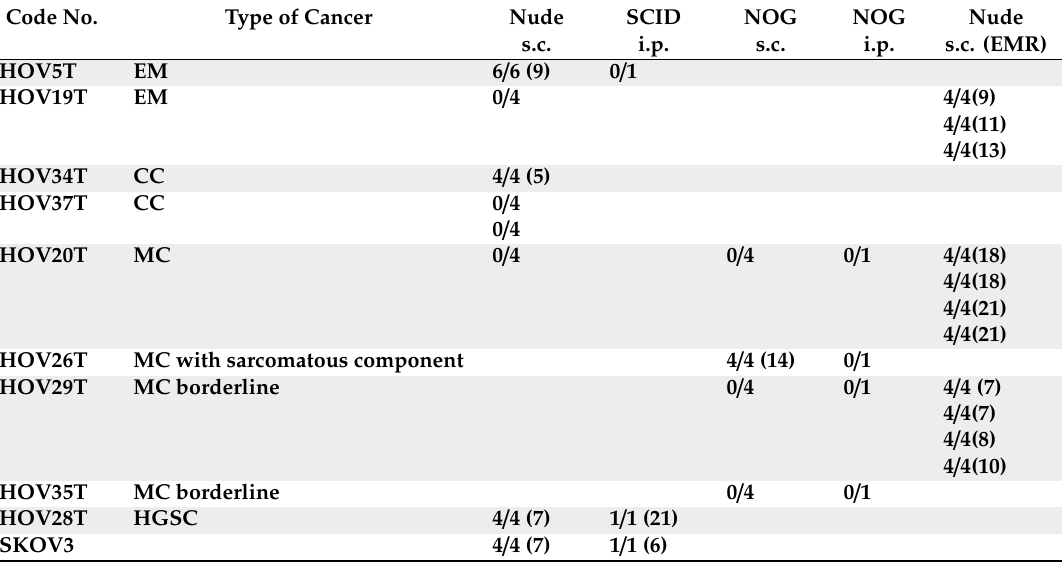
Table 3. Summary of xenograft transplantation of HOV lines and SKOV3. Code